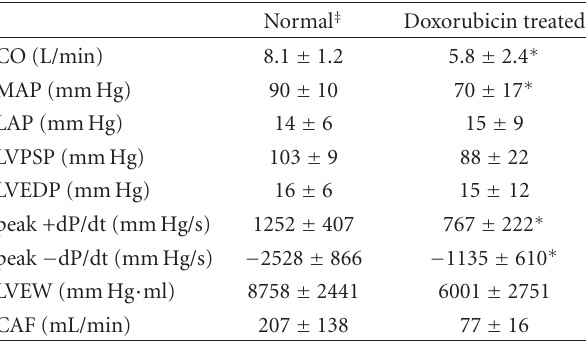
Table 3: Hemodynamics in doxorubicin-treated and normal calves. Normal ‡ Doxorubicin treated CO (L/min) 8.1 ± 1.2 5.8 ± 2.4 ∗